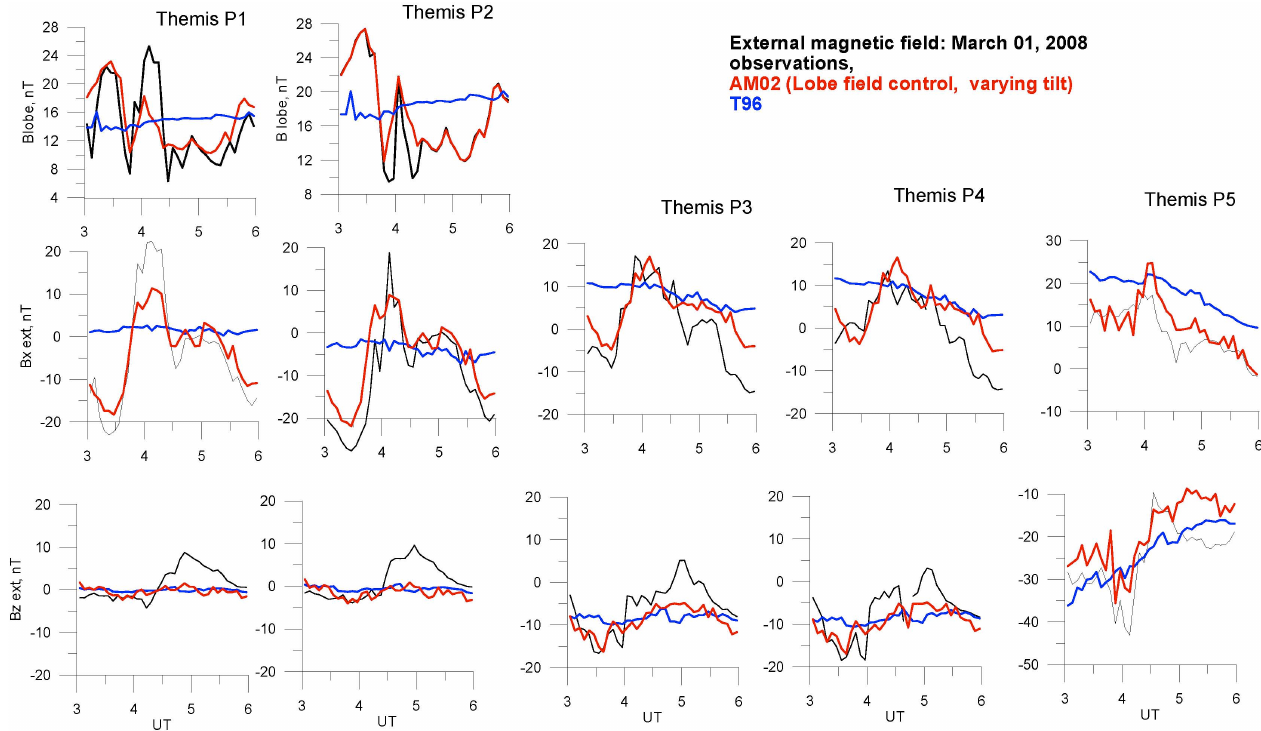
Fig. A1 Red curves show the magnetic field of AM02, blue curvesshow the results of T96, black curves are the observed magnetic fieldat the five TH probes (P1 to